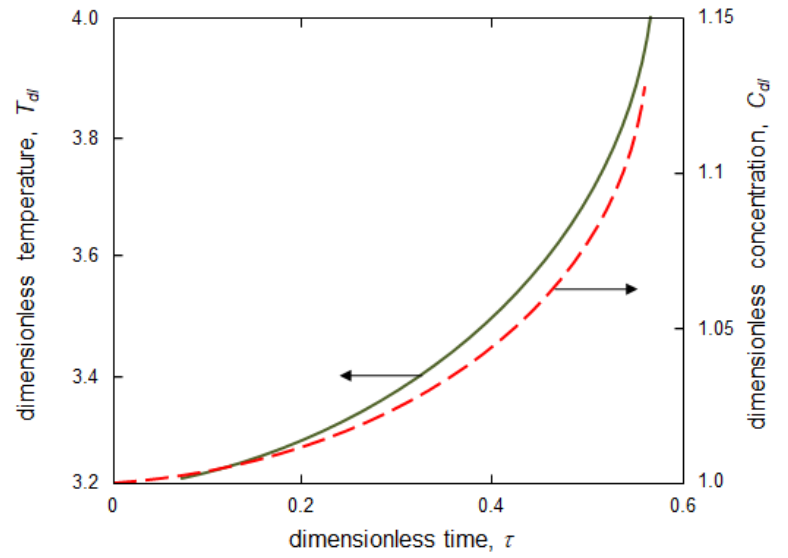
Figure 4. Dimensionless temperature T dl and solute concentration C dl in a binary supercooled melt as functions of dimensionless time τ